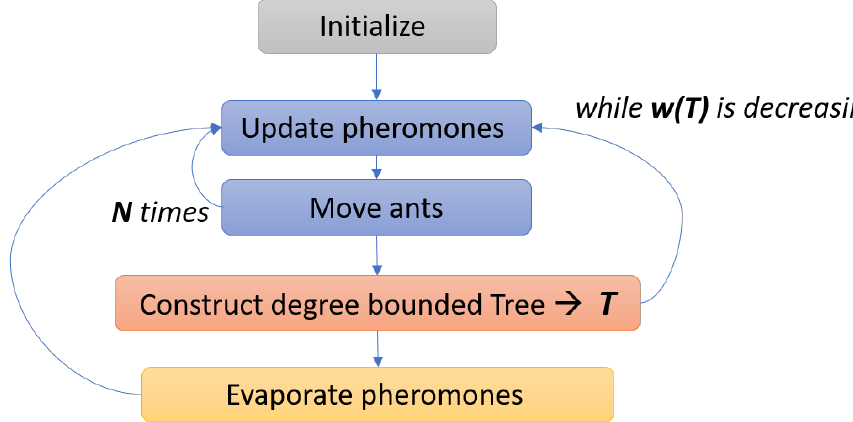
Figure 7. The Ant-Colony algorithm flow.